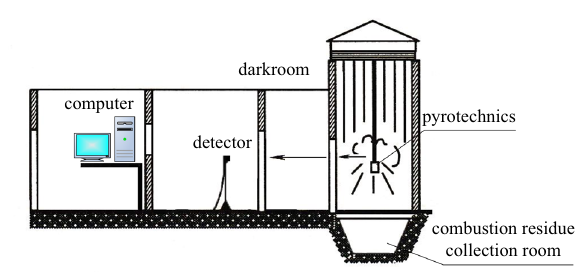
Figure 1. Schematic of the experimental set-up.